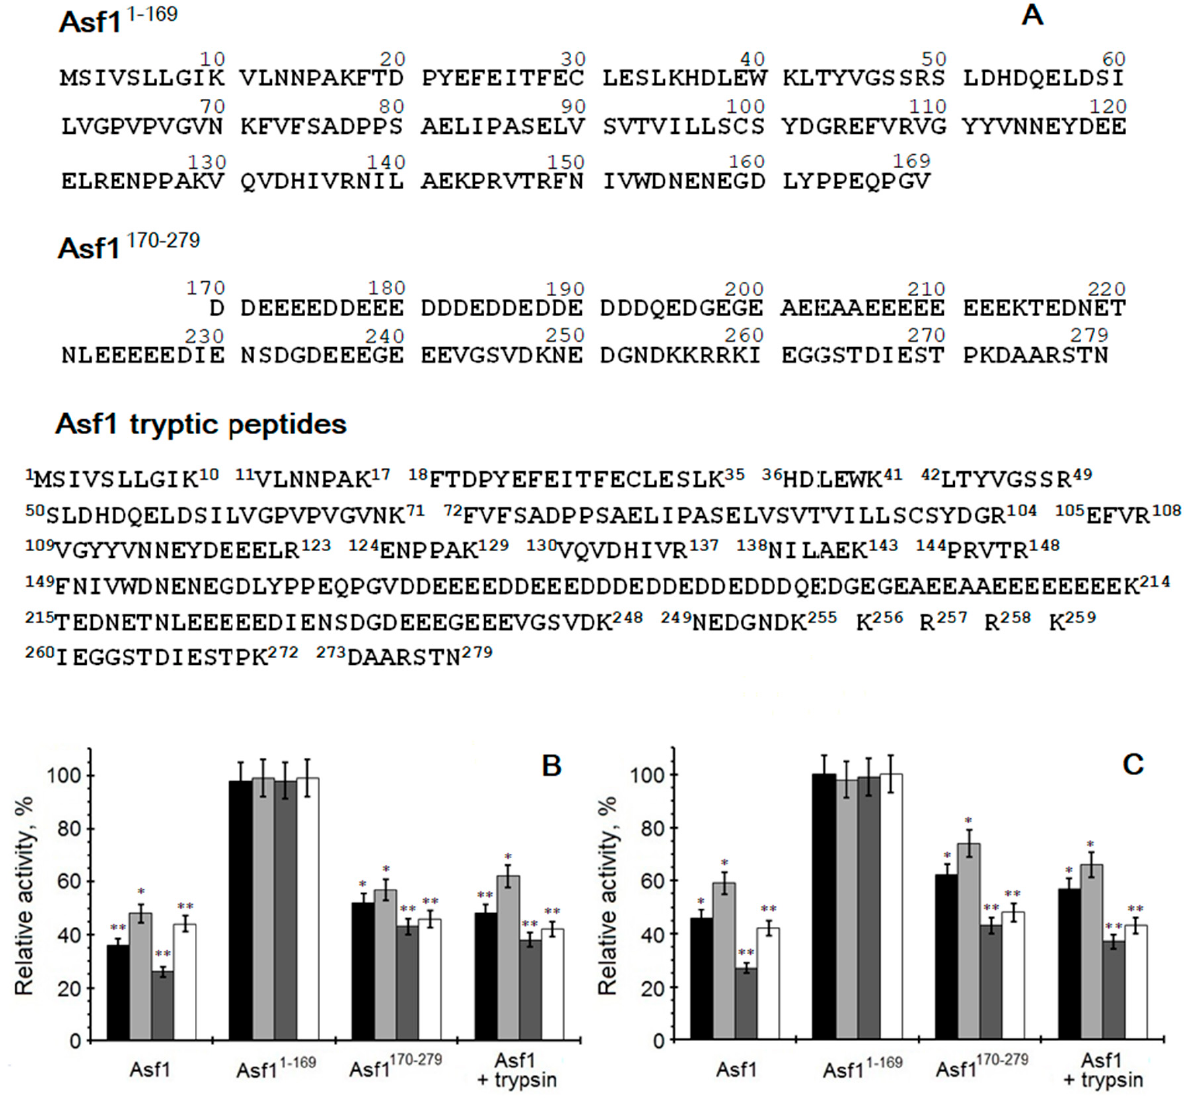
Figure 5. Comparison of effect of different Asf1 proteins/peptides ( A ) on CK2 activities from human ( B ) and yeast ( C ). Phosphorylation activity of CK2 α (black bars), human CK2 α 2 β 2 or yeast CK2 α 2 ββ ’ (light grey bars), and CK2 α ’ (dark grey bars) and human CK2 α ’ 2 β 2 or yeast CK2 α ’ 2 ββ ’ (white bars), was measured in the presence of Asf1 or its fragments. The relative activity is given in reference to CK2 incubated with trypsin and STI as control. The experiment was carried out in the presence of 10 µM P2B and 20 µM ATP. * and ** indicate significant difference compared to the controls ( p < 0.05 , p < 0.01).